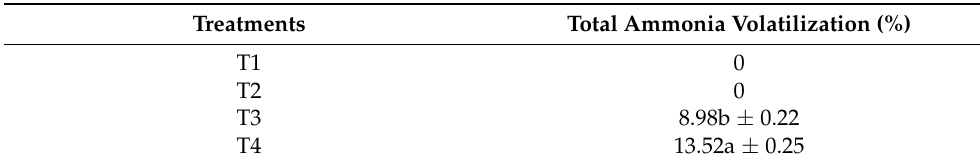
Table 5. Accumulation of ammonia volatilization for 10 days of